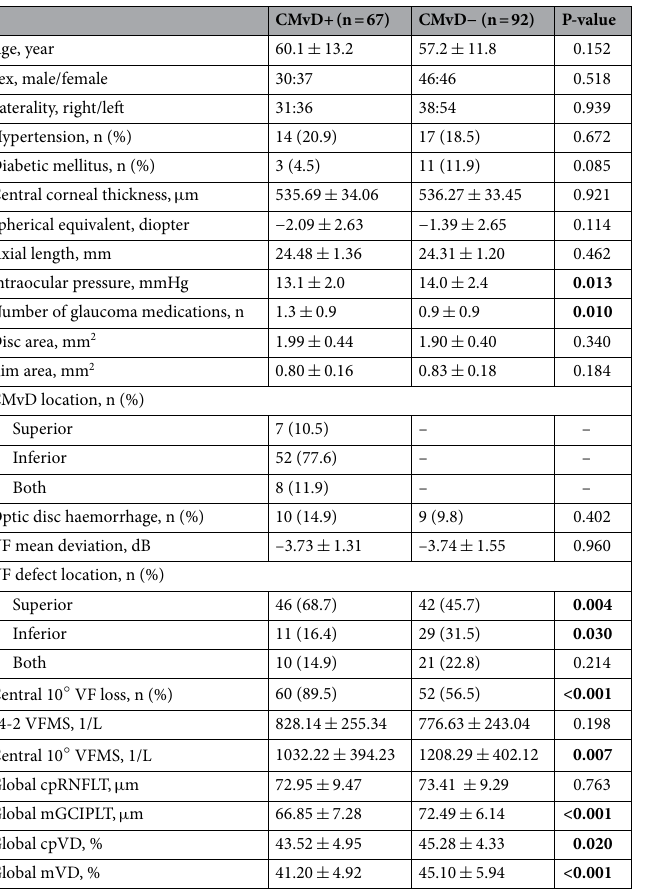
Table 1. Comparison of the baseline characteristics between open-angle glaucoma eyes with and without choroidal microvasculature dropout. CMvD choroidal microvasculature dropout, cpRNFLT circumpapillary visual field, VFMS visual field mean sensitivity. Significant values are in